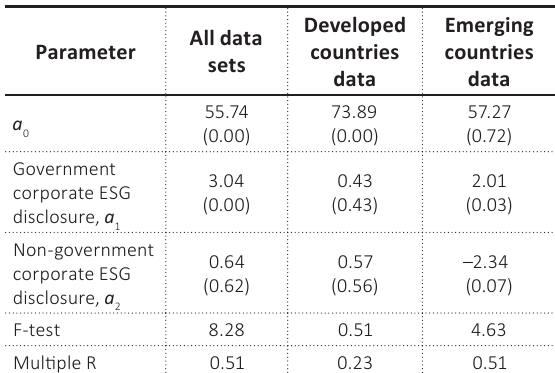
Table 5. Multiple regression analysis: SDGI score